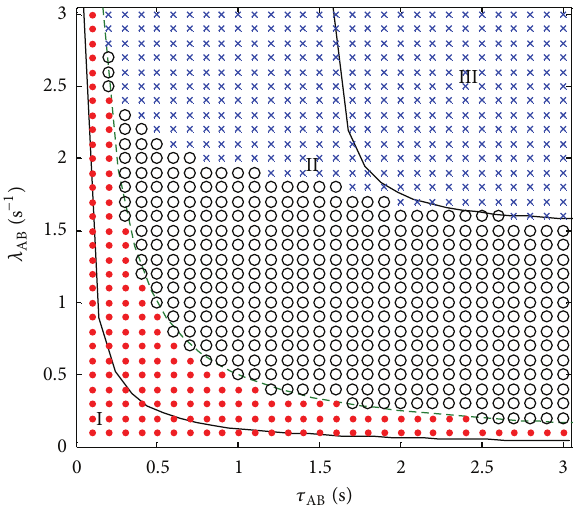
Figure 6: Stability results of binary platoon according to Holland’s analytic stability criterion [24] (color